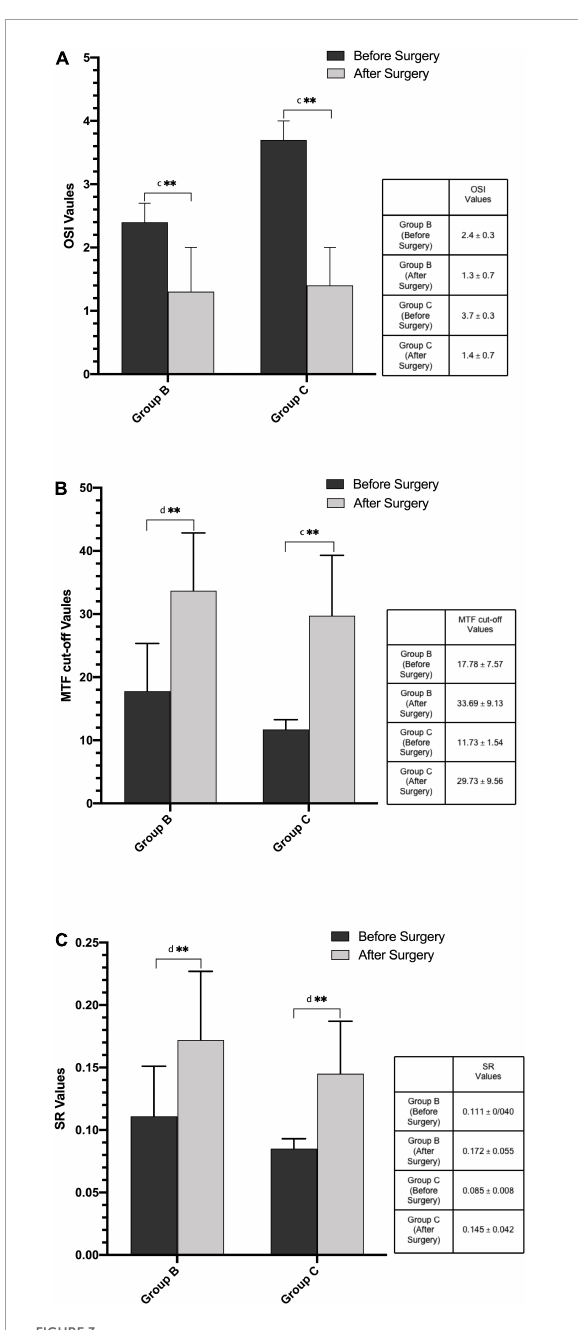
FIGURE3 (A) Preoperative and postoperative OSI values in Group B and Group C. (B) Preoperative and postoperative MTF cut-off values in Group B and Group C. (C) Preoperative and postoperative SR values in Group B and Group C. (MTF cut-off, modulation transfer function cut-off frequency; OSI, objective scatter index; SR, Strehl ratio; c Paired t -test; d Wilcoxon test; ** P < 0.01: compare between the preoperative and postoperative